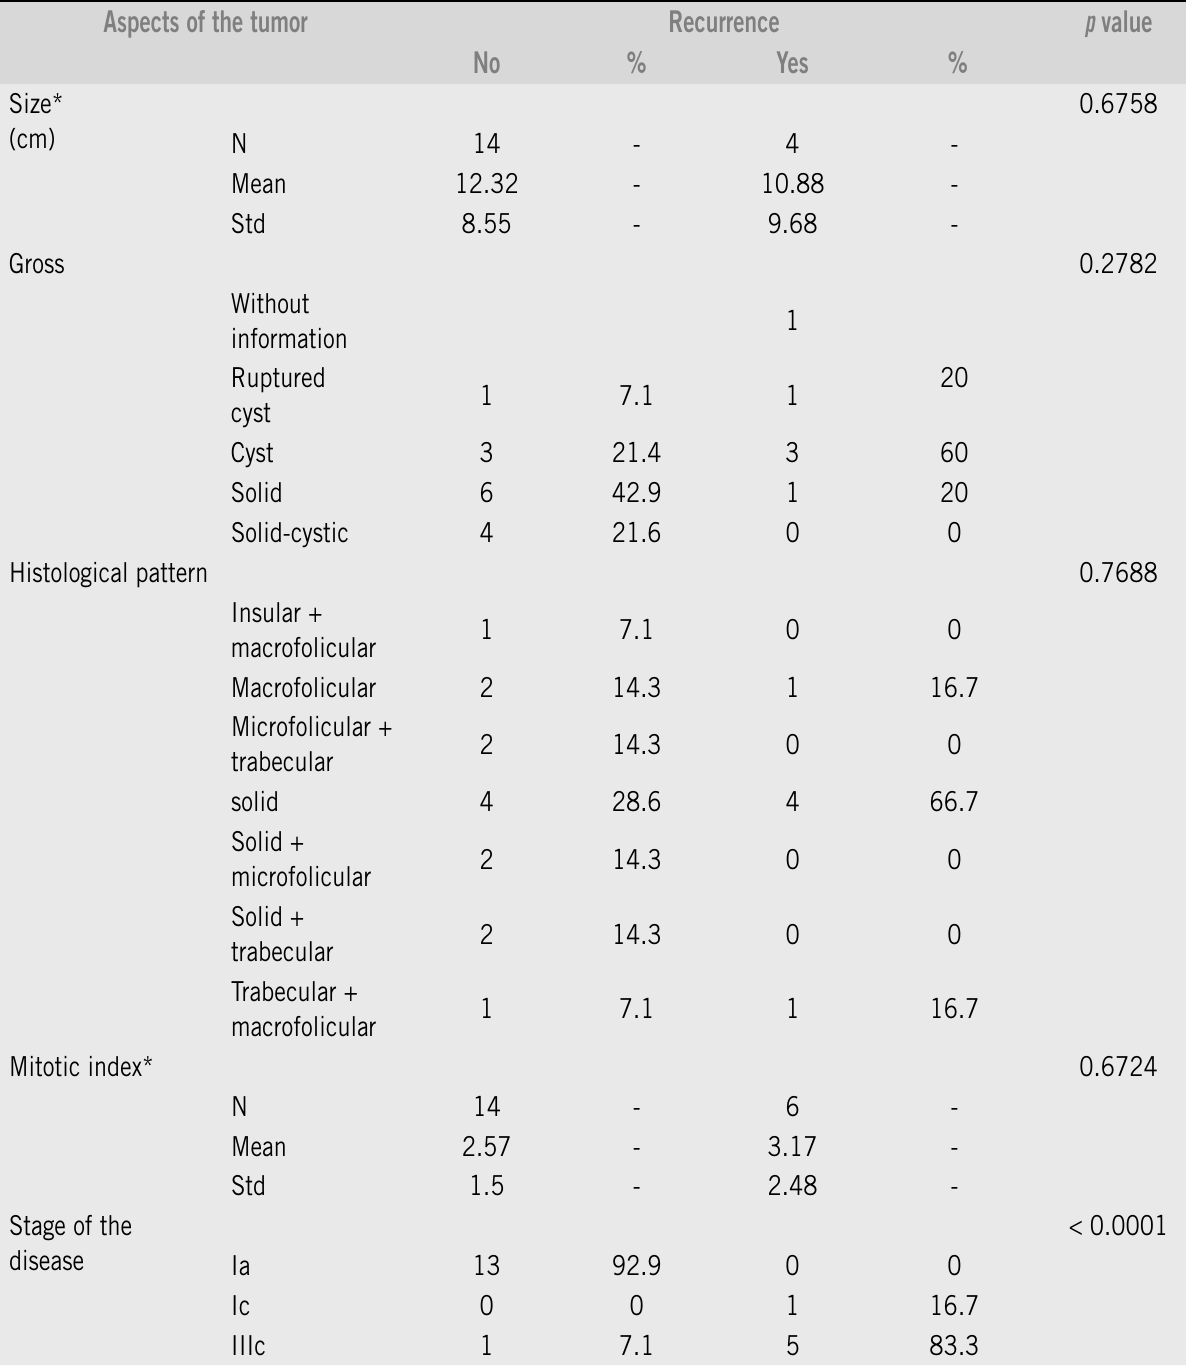
Table 2 recurrence of granulosa cell tumor and its relation to different aspects Aspects of the tumor recurrence p